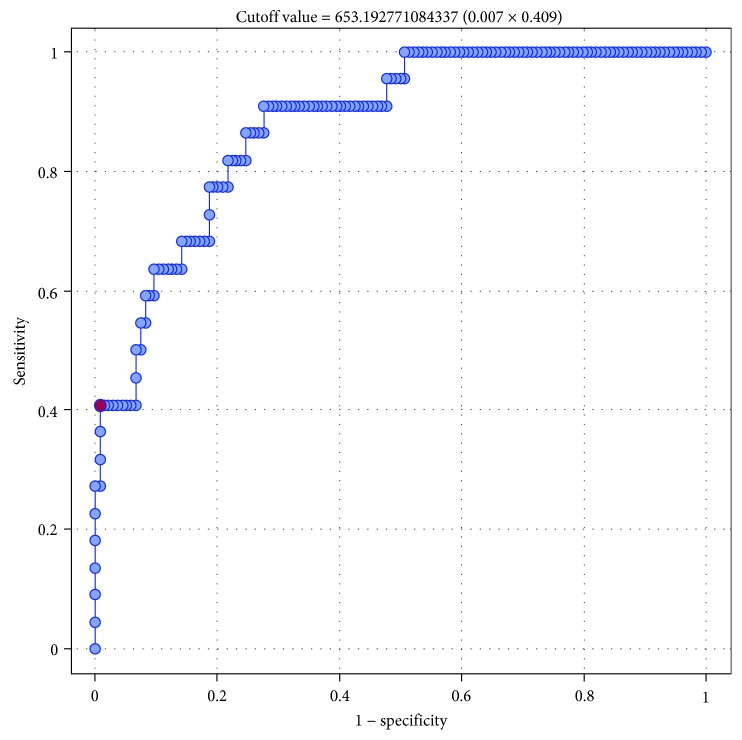
ROC curve—relationship between sFlt-1/25(OH)D index and occurrence of preeclampsia (AUC 87.96%).